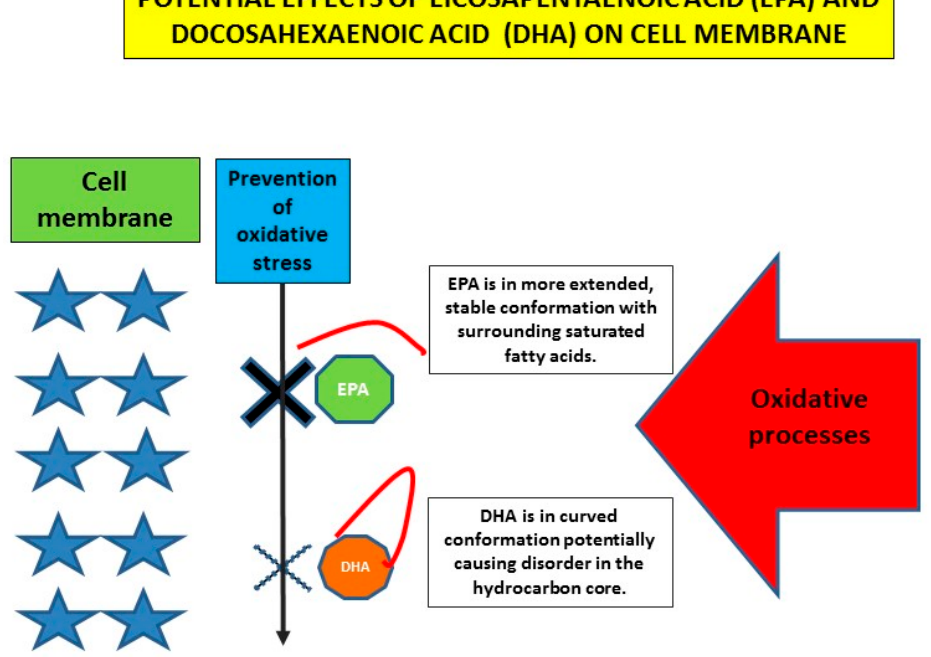
Figure 3. Schematic representation of potential difference between EPA and DHA at the level of the plasma membrane (created partly on information and data from [39,62]).